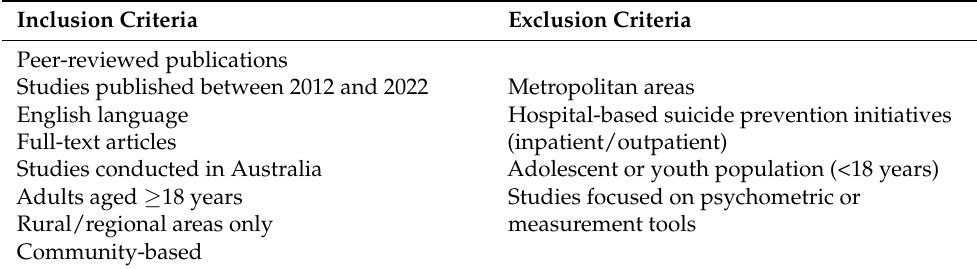
Table 2. Inclusion and exclusion